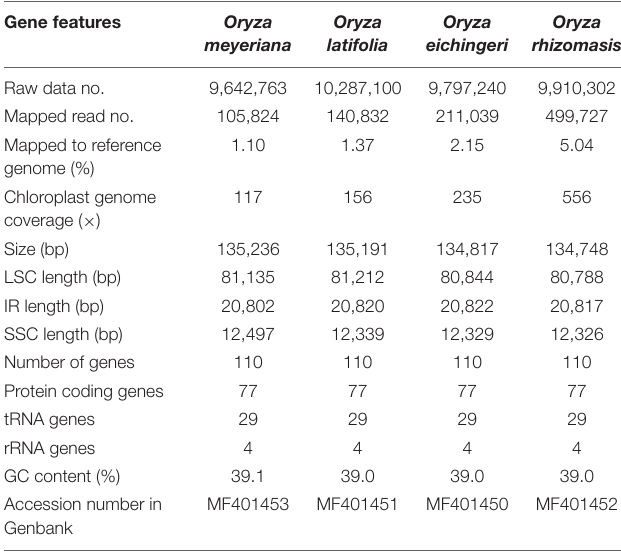
TABLE 2 | Summary statistics for assembly of four Oryza species chloroplast